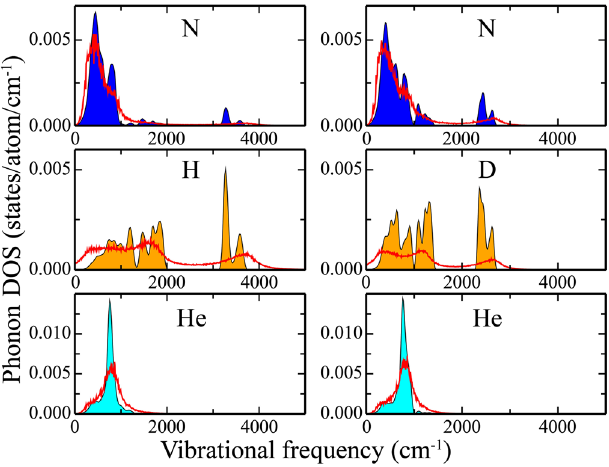
FIG. 4. Vibrational density of states (VDOS) for the Pnma phase HeNH 3 (left) and HeND 3 phase (right). Colored areas under black curves give the phonon DOS of N (blue), H = D, (orange) and He (cyan) from static phonon calculations at 0 K. The red lines represent the vibrational DOS of each atomic species in the superionic phase at 100 GPa þ 2000 K, calculated from the Fourier transform of the velocity autocorrelation function. Note that the zero (nonzero) vibrational DOS at zero frequency is due to the fixed (diffusive) behavior of O, H = D, and He in the superionic phase